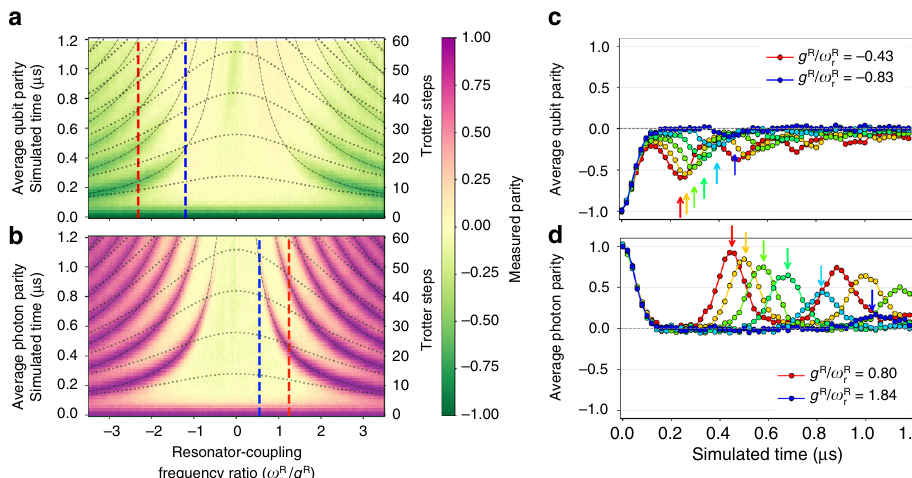
Fig. 2 Qubit and resonator parity dynamics of the quantum Rabi model in the degenerate-qubit case. Measured dynamical landscapes for a qubit and b photon parity dynamics for a broad range of parameters up to 60 Trotter steps, with the extreme DSC regime in the centre decreasing to weaker USC near the edges. The data show clear Gaussian-shaped collapses for all r , along with the characteristic plateaus of DSC. Qubit revivals are observed up to r ∼ 0.8, while photon parity shows clear revivals up to r ∼ 1.8. Vertical line cuts for c qubit and d photon parity are plotted for evenly spaced ω R and blue dashed lines in a , b , respectively. For r ≳ 1.5, some deviation from the expected revival time in the photon parity results from a small residual Kerr- type nonlinearity in the resonator (see also Supplementary Fig. 9) and is correlated with signi fi cant photon populations. Arrows in c , d show expected revival times for each slice. In this and following fi gures, coupling ratios were calculated using the observed simulated coupling of g /2 π = 1.79